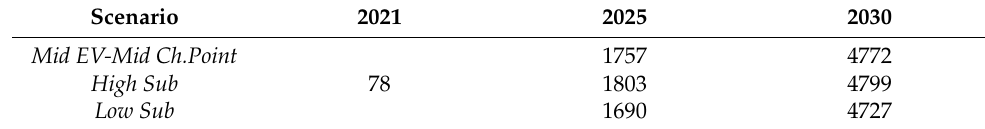
Table 15. Total available charging stations per time period for the three scenarios.